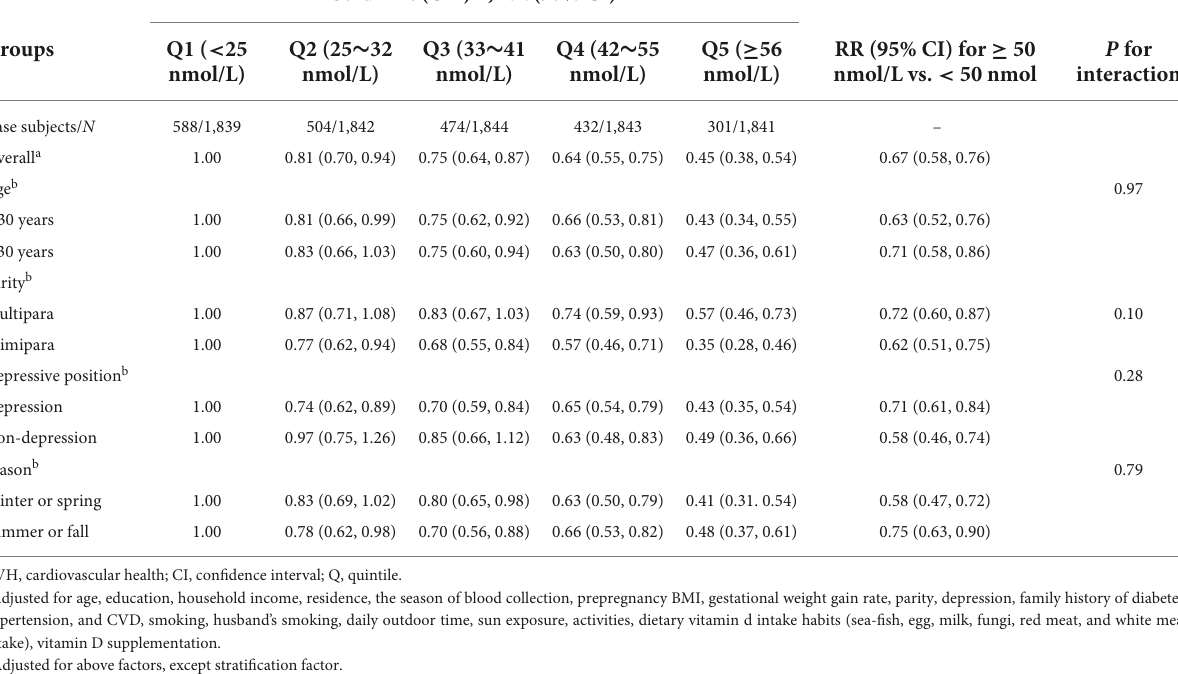
observed between 25(OH)D concentrations and poor CVH risk,